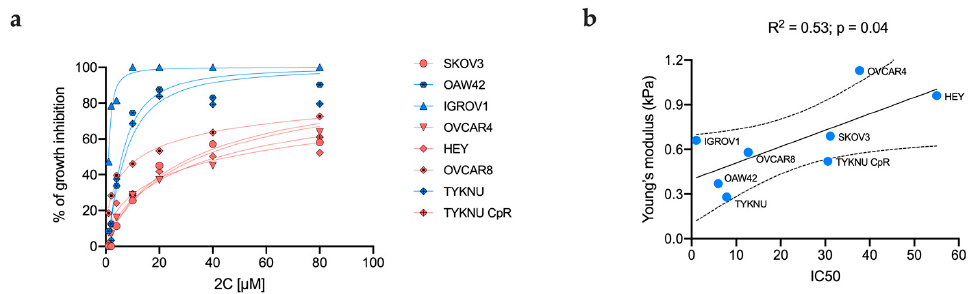
(IC50 = 30.58 µ M vs. 7.86 µ M, respectively).